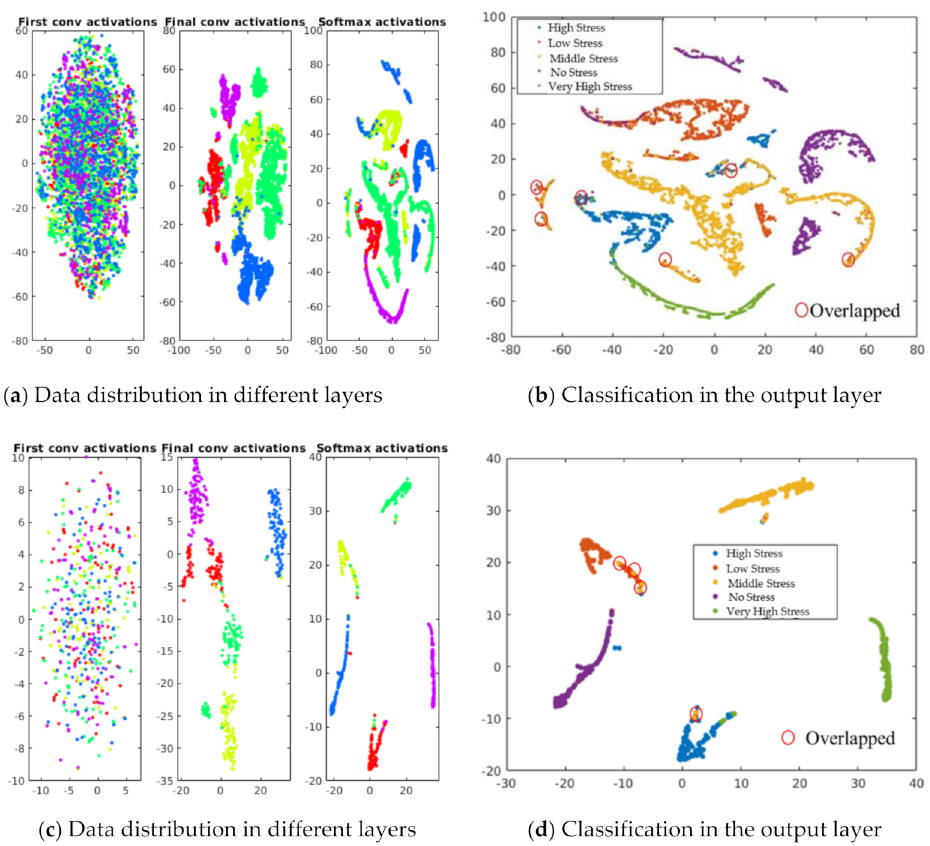
Figure 11. Visualization of data distribution using t-SNE (t-distributed stochastic neighbor embed- ding)